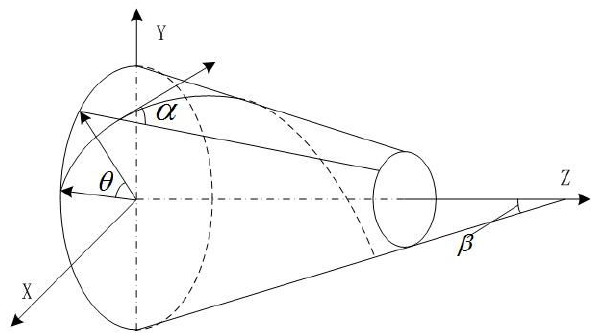
Figure 3: The sketch of the head of